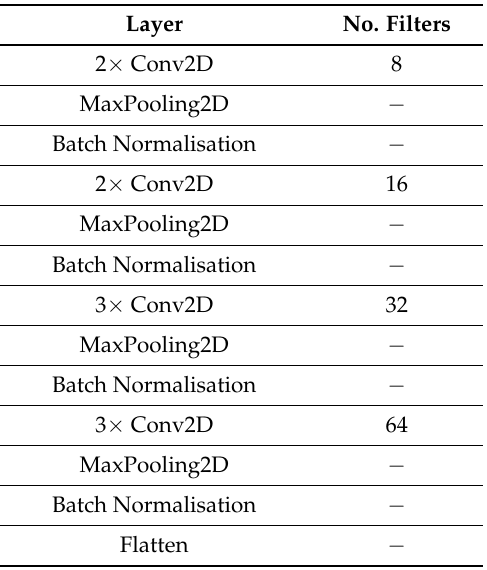
Table 1. Feature embedding CNN